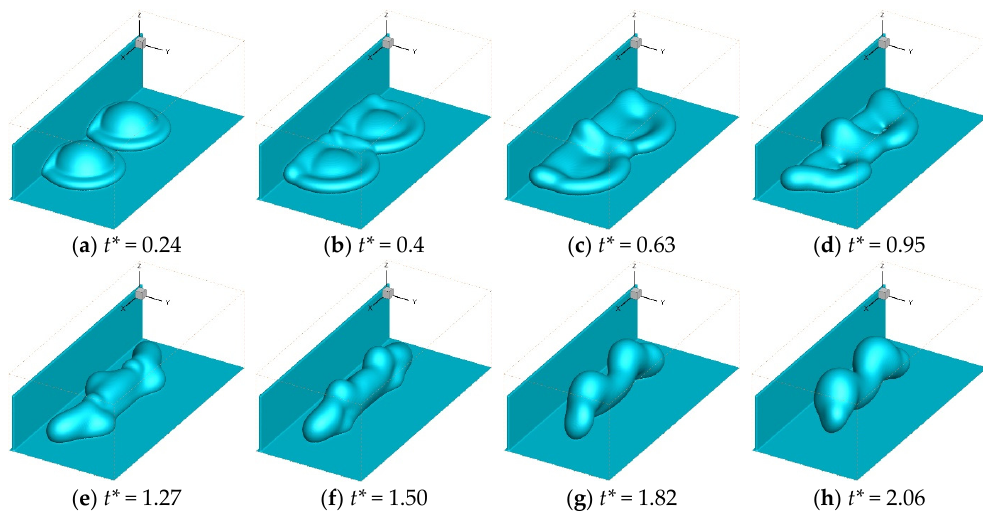
Figure 5. Snapshots of two droplets simultaneously impacting the S2 surface at L x * = 1.67 and L y * = 0.58. The morphologies at different moments are illustrated in ( a )–( h ).